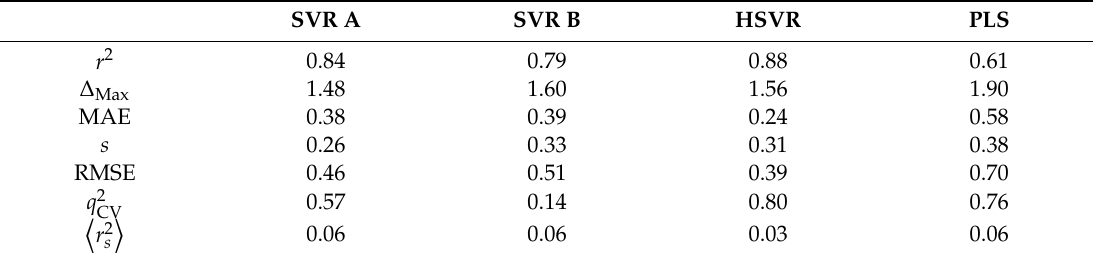
Statistic evaluations, namely correlation coe ffi cient ( r 2 ), maximum residual ( ∆ Max ), mean absolute error (MAE), standard deviation ( s ), root mean square error (RMSE), and 10-fold cross-validation correlation coe ffi cient ( q 2 ) evaluated by SVR A, SVR B, HSVR, and PLS in the CV training